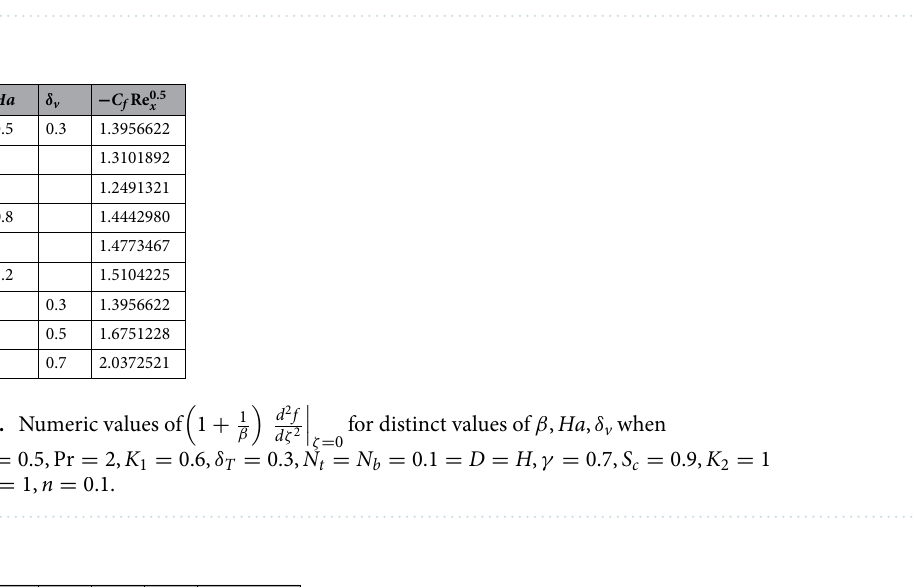
Figure 20. φ ( ζ ) for various δ .